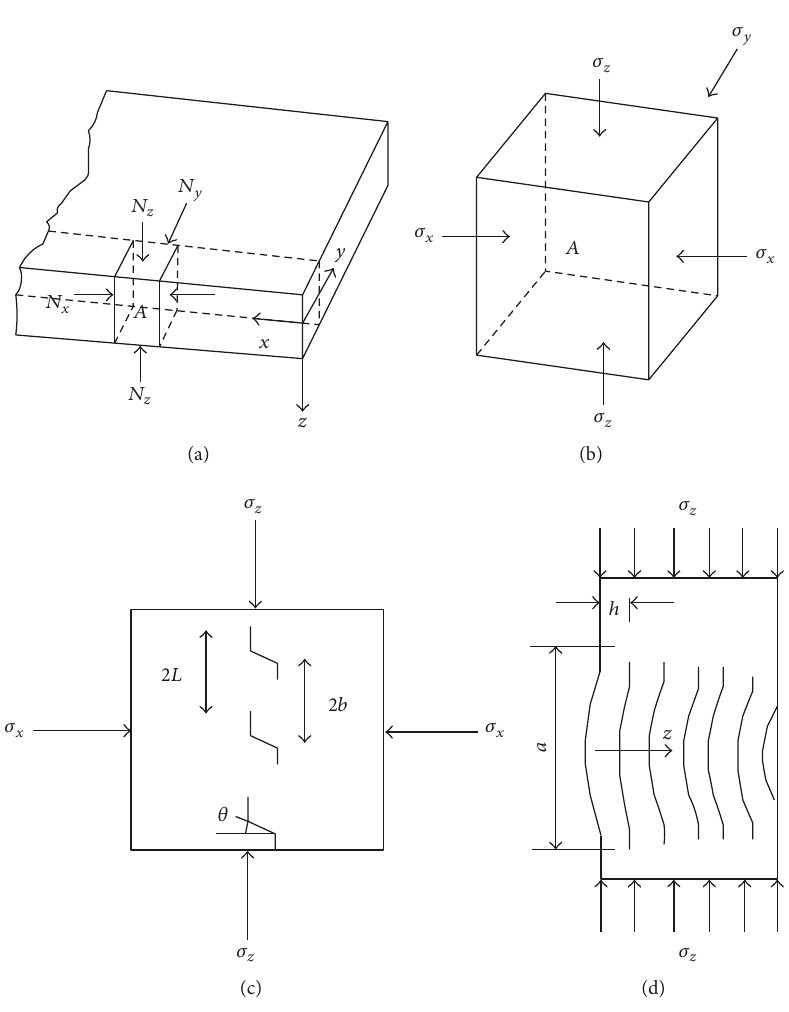
Figure 1: The formation process of the layer-crack plate structure in coal wall near a roadway.